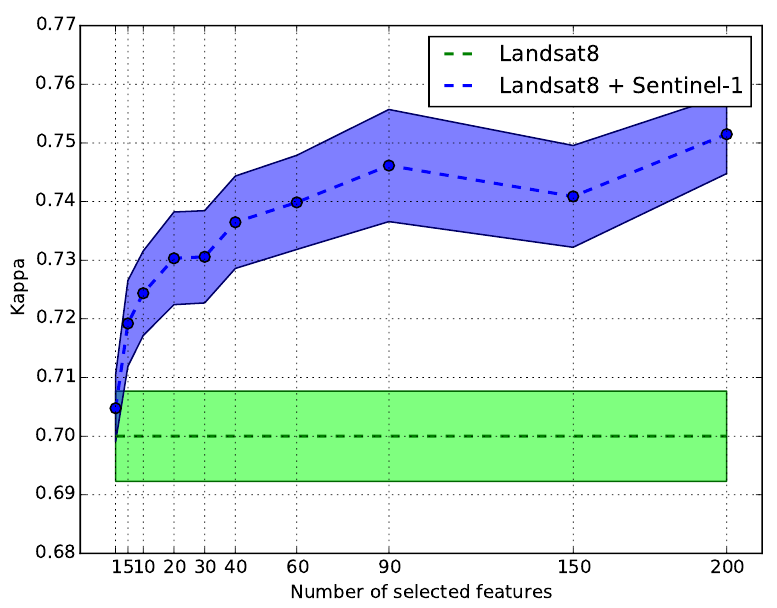
Figure 2. Kappa coefficient of the classification using both Landsat8 and Sentinel-1 images as a function of the number of SAR features sorted by importance. The results with Landsat8 data alone are plotted as a baseline. Line width indicates 95% confidence intervals.